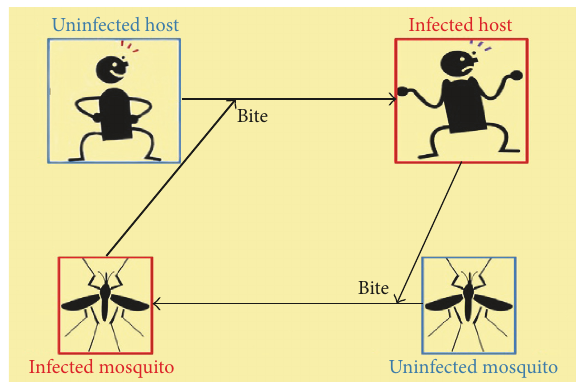
Figure 1: The mosquito-human transmission cycle. An infectious mosquito bites a susceptible, uninfected human and transmits the virus via saliva. Once the human becomes infectious (usually accompanied by symptoms), the human can transmit the pathogen to an uninfected mosquito via the blood the mosquito ingests. Source . Figure 1 is reproduced from Manore and Hyman (2016)